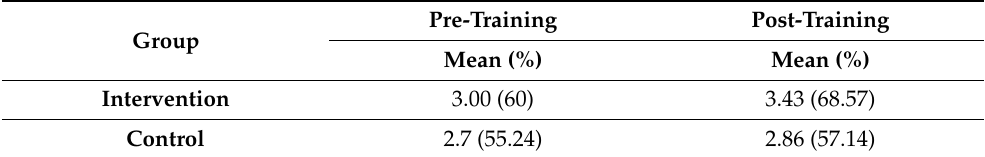
Table 3. Achieved scores by intervention and control group in pre- and post- training multiple-choice-test. Group